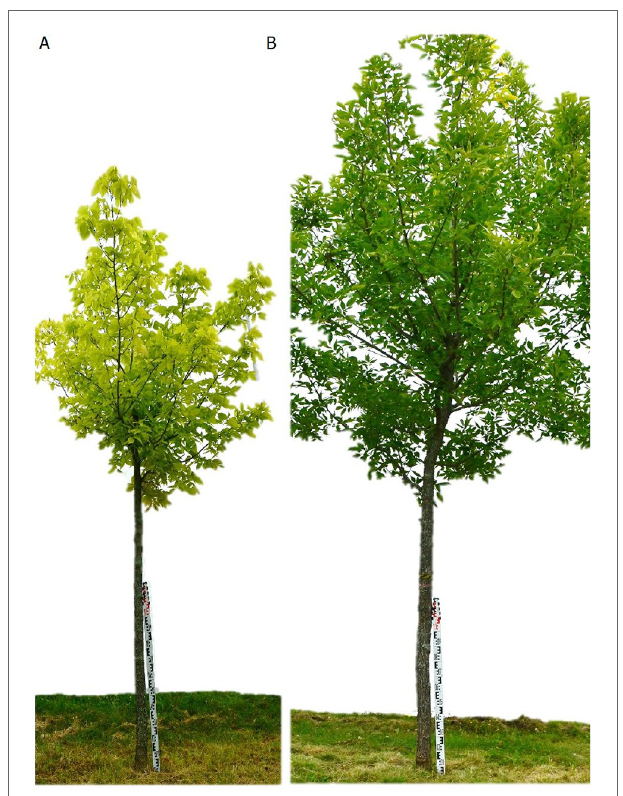
FIGURE 1 | Examples of control trees of (A) Celtis and (B) Fraxinus taken at the end of the experiment period in 2017. Ruler for scale is 1m in length.